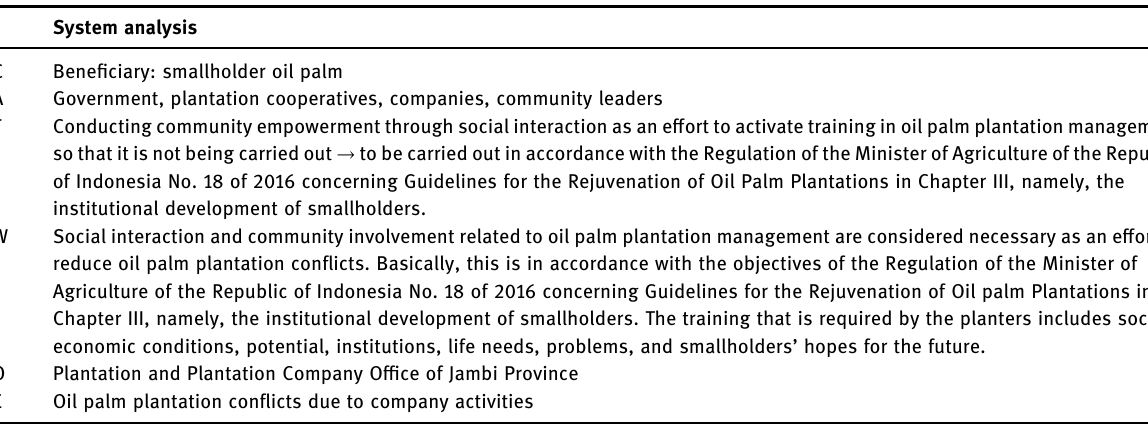
Table 3: CATWOE analysis System